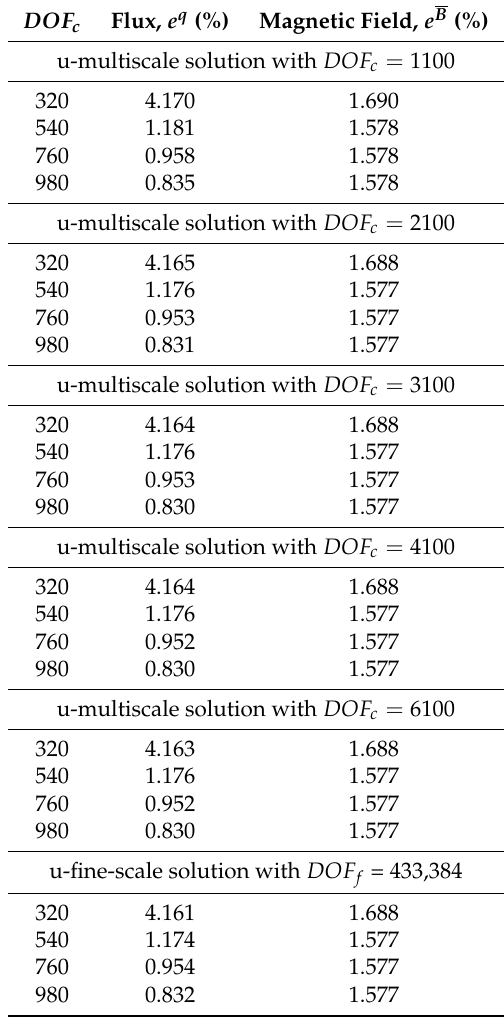
Table 1. Relative errors for flux and magnetic field with a different number of multiscale basis functions for 10 × 10 meshes. DOF f =